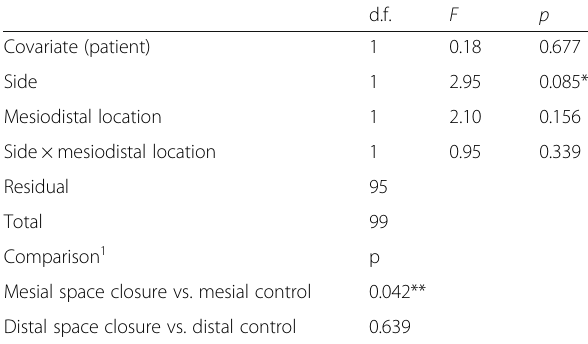
Table 1 Non-parametric MANCOVA on ABL (difference between pre- and post-treatment levels) at different mesiodistal locations (mesial or distal), and side memberships (space closure or control)